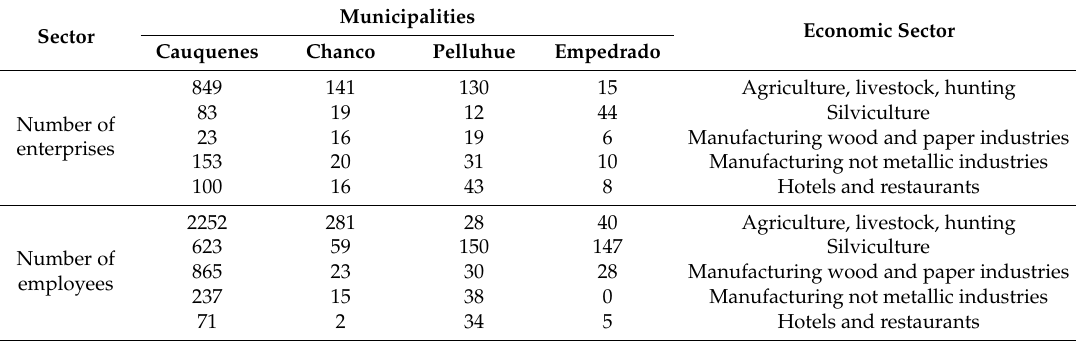
Figure 2. Current erosion in the study area [30]. Table 2. Number of enterprises and number of workers employed per economic sector in the study